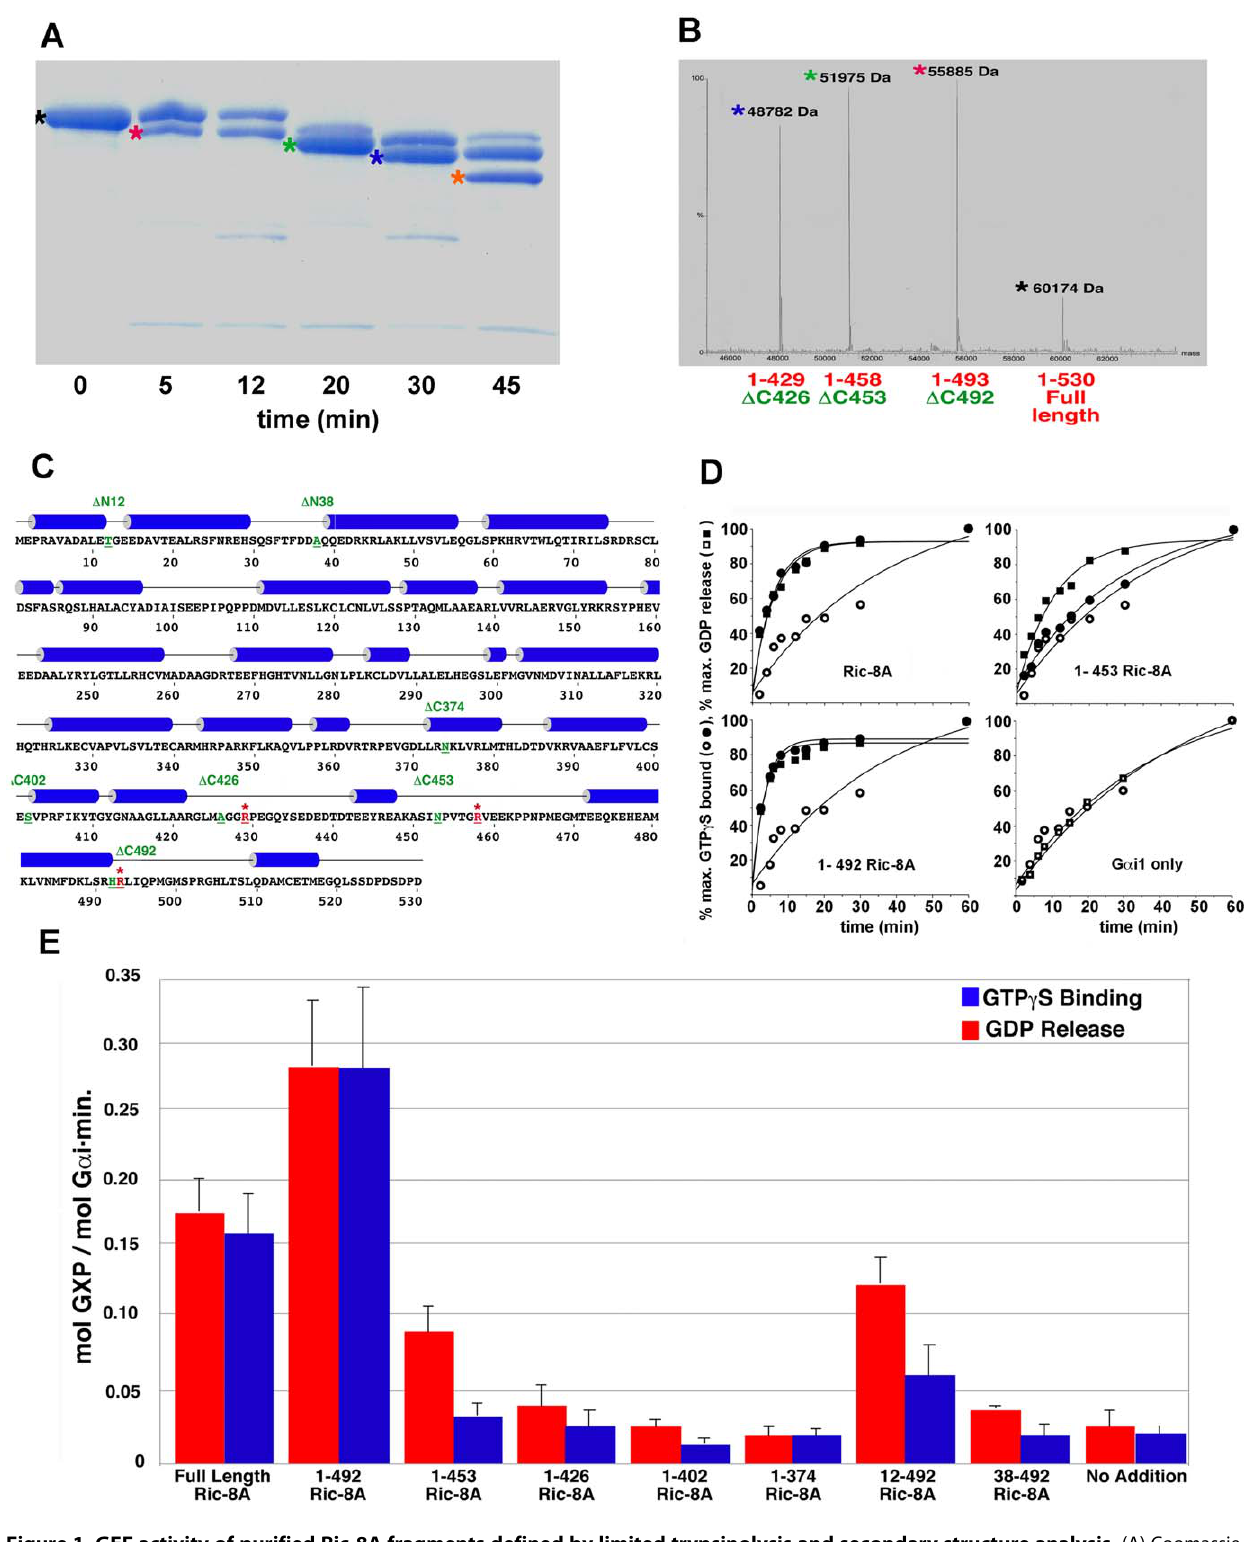
Figure 1. GEF activity of purified Ric-8A fragments defined by limited trypsinolysis and secondary structure analysis. (A) Coomassie- stained SDS PAGE analysis of Ric-8A after trypsinization for the times indicated below each lane; unique fragments are identified by colored asterisks. (B) Electrospray mass spectrometric analysis of Ric-8A tryptic digest fragments extracted from the SDS PAGE gel shown in panel A; peaks identified by asterisks refer to corresponding bands shown in panel A. Fragment masses (Da) are indicated at each peak position. (C) Amino acid sequence of rat Ric-8A; cylinders indicate helical segments predicted using JPRED [51]. Residue codes colored red indicate sites of proteolytic cleavage (see panel A). Residue codes in green indicate N or C-termini of recombinant Ric-8A fragments engineered to coincide approximately with proteolytic sites or predicted secondary structure boundaries: D C492 denotes the Ric-8A fragment comprising residues 1–492. Both N-terminal truncations D N12 and